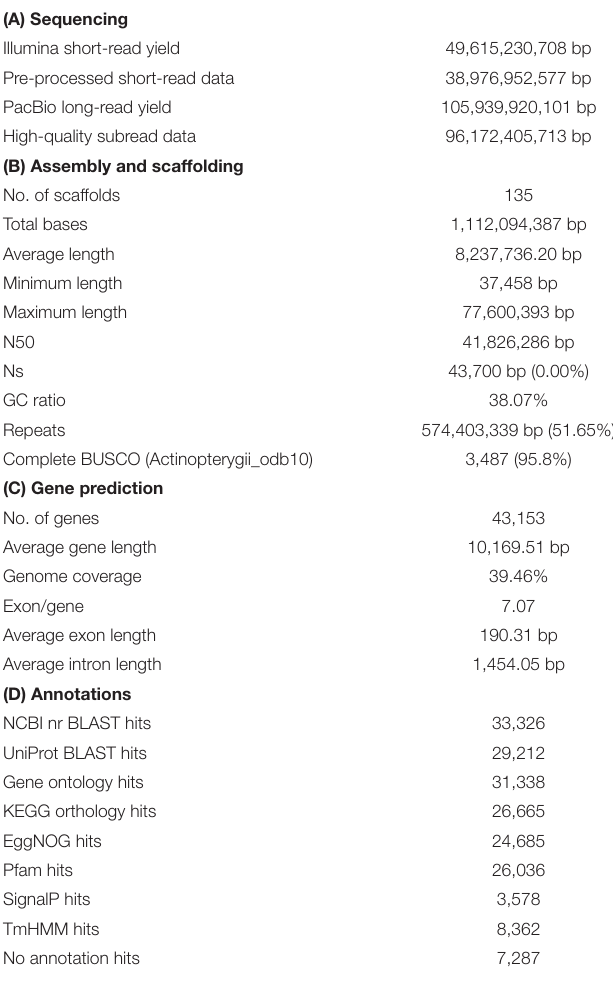
TABLE 1 | Summary of the sequencing for annotation of the Misgurnus mizolepis draft